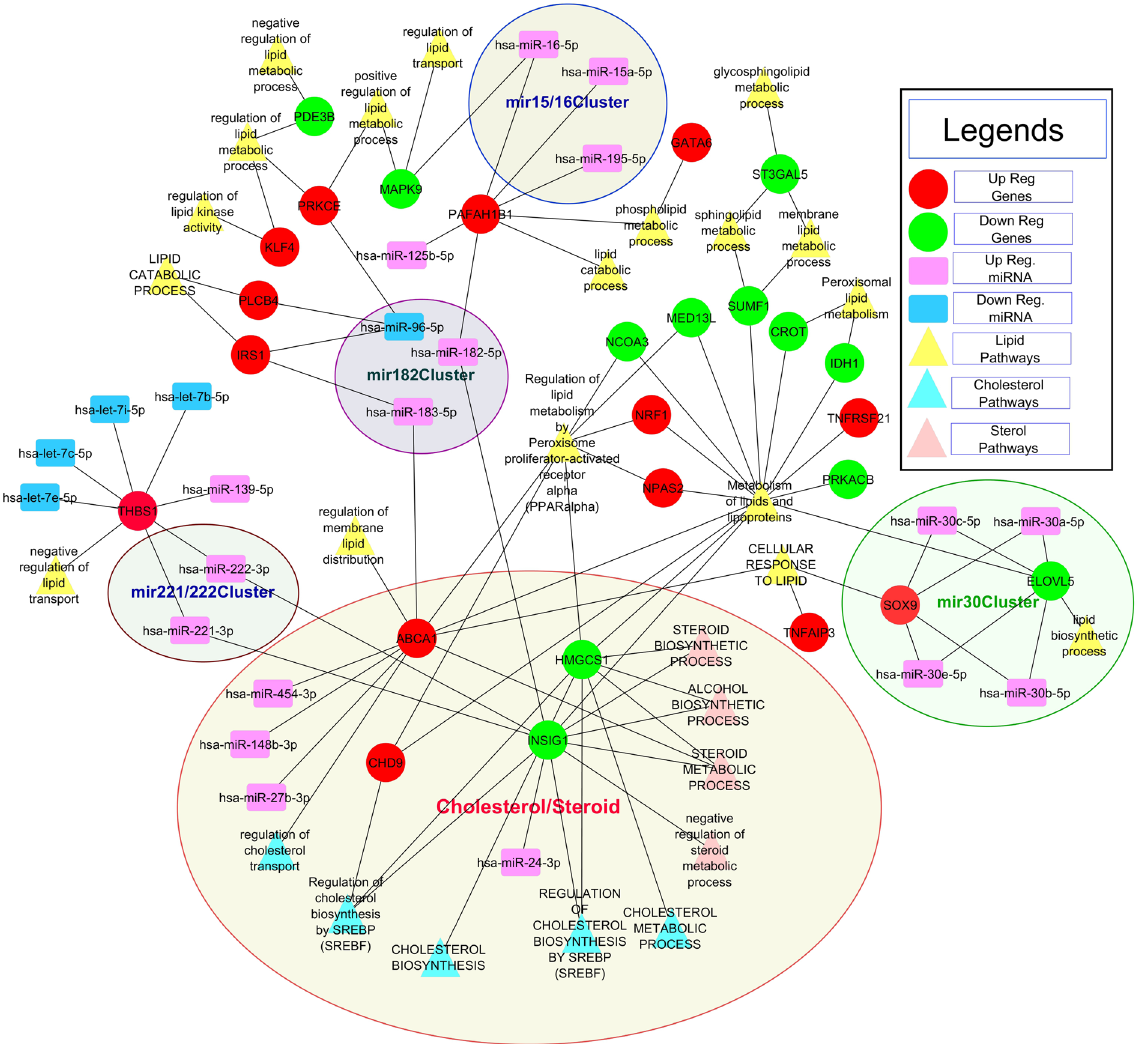
Figure 9. Network of the Differentially expressed and KS statistics based enriched mRNA-miRNA functional interaction and the cholesterol/lipid pathways associations” (Also refer to corresponding Supplementary Figs S1A, S2A and S2B and related network in